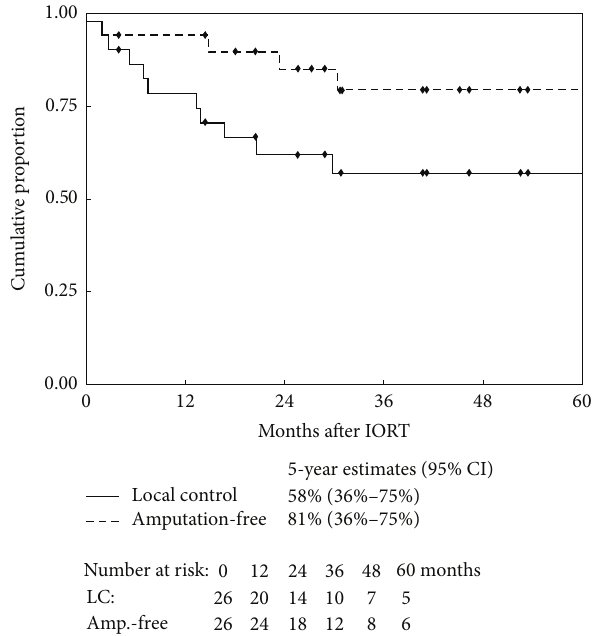
Figure 1: Kaplan-Meier probability distributions of local disease control and free of amputation after oncologic reresection and intraoperative radiotherapy (IORT) with 5-year estimates. CI = confidence interval.